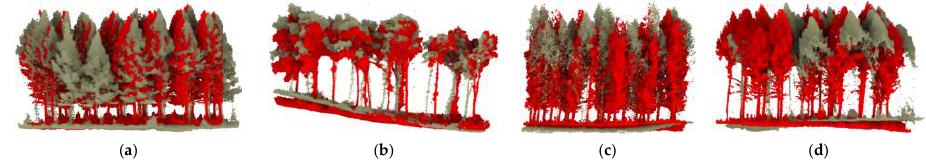
Figure 5. Coarse alignment of the registered TLS data (red points) and UAV data (gray points). The UAV data in ( a – c ) were obtained from the LiDAR system and the UAV data in ( d ) were generated from digital images. From the coarse alignment results, the attitudes of the registered TLS data were ba- sically consistent with that of the corresponding UAV data, which indicates a potential for correct fine registration of the registered TLS data and the UAV data. To quantitatively assess the quality of coarse alignment, we calculated the distance between the correspond- ing tree stems in the two related point clouds and summarized the average distance in Table 1.